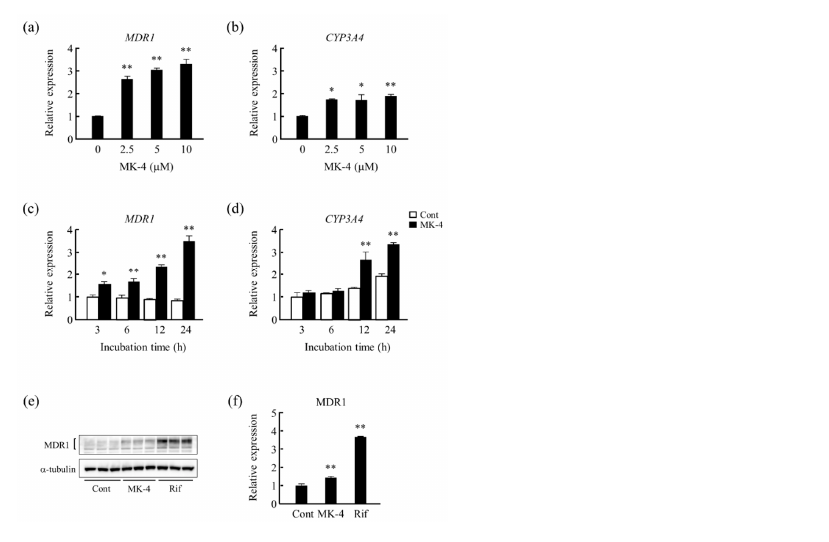
Figure 1. Effect of menaquinone-4 (MK-4) on drug metabolism-related gene expression in LS180 cells. The effects of different (2.5–10 μ M) concentrations of MK-4 for 24 h on ( a ) CYP3A4 and ( b ) MDR1 mRNA levels in LS180 cells were analyzed. The effects of MK-4 on ( c ) MDR1 and ( d ) CYP3A4 mRNA levels were measured after 3, 6, 12, and 24 h of treatment. mRNA levels were measured using quantitative RT-PCR. Relative mRNA levels of the genes were normalized to that of eukaryotic translation elongation factor 1 α 1 mRNA. ( e , f ) Effects of MK-4 and rifampicin (Rif) treatment on MDR1 protein levels were analyzed using western blotting after 24 h of treatment. Data are expressed as mean ± standard error of the mean, n = 3, * p < 0.05, ** p < 0.01 vs MK-4 (0 μ M) ( a , b ), or control (Cont) ( c , d , f ). MDR1 , multi-drug resistance; CYP3A4 , cytochrome P450 3A subfamily 4.